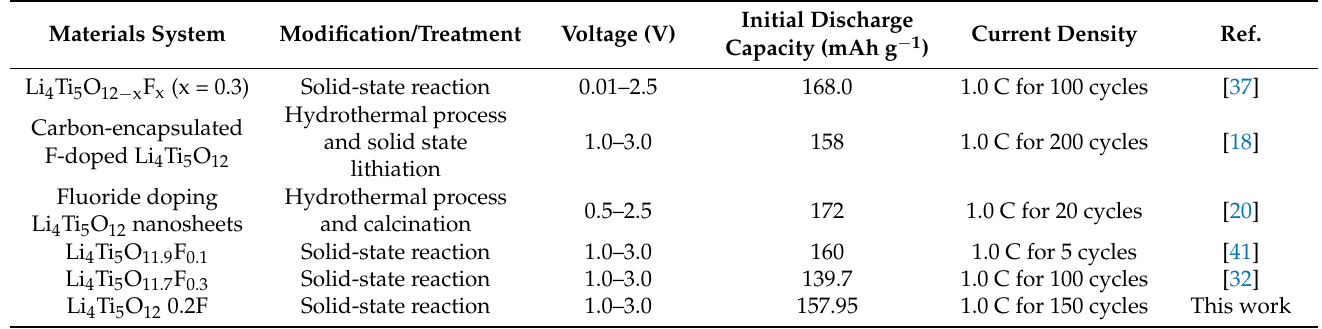
Table 2. Summary of the F-doped LTO materials and their electrochemical